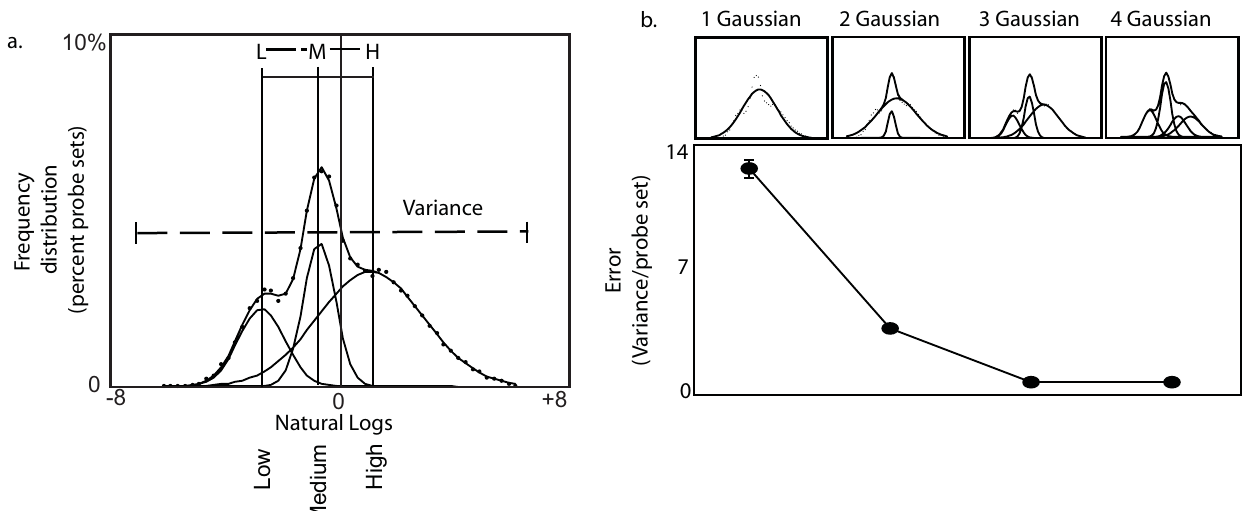
Figure 4. Global gene expression is described by three log-normal distributions. We found that the distribution log-transformed gene expression levels can be described by three log-normal curves. Three normal distributions were fit to log-transformed Affymetrix micro-array data that was processed and summarized using MAS 5.0. The fit error in all cases was minimal and could not be improved significantly by adding additional log-normal curves, whereas trying to fit data to one or two log-normal distributions significantly increased error. Matlab fitting algorithms perform well across a wide range of distribution patterns (supplemental figure S6).